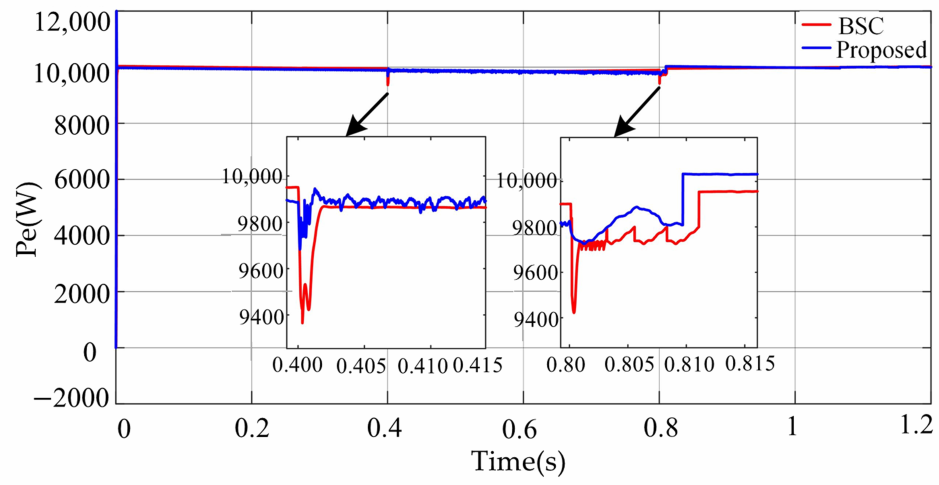
Figure 15. Output power result during the transition process.